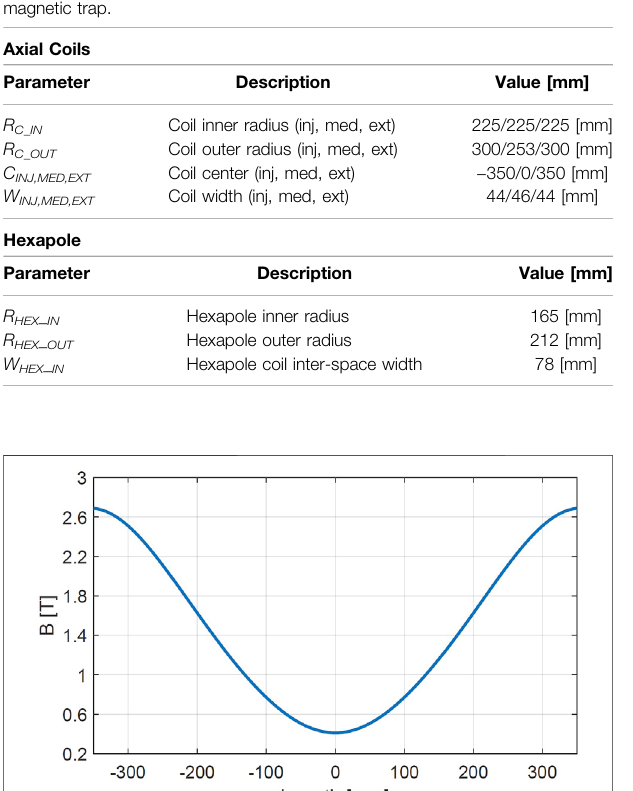
TABLE 2 | Simulated geometrical dimensions of the coils composing the magnetic trap.